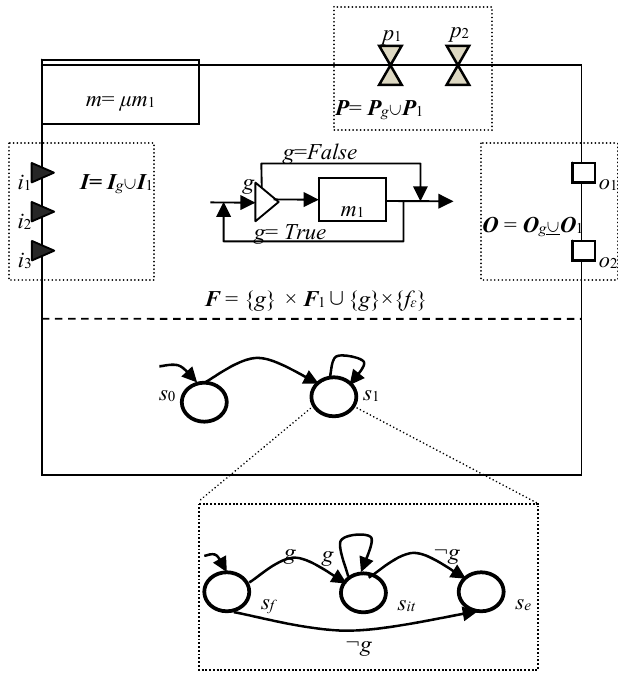
Figure 10. The diagram definition of the Iterate operator.